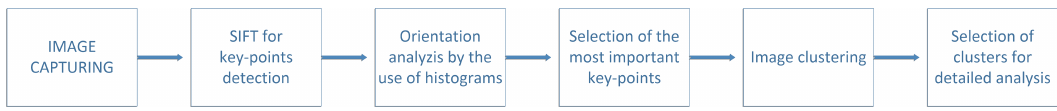
Figure 3. The captured image goes through the following stages of processing in the proposed system: global and local features extraction and comparison. In the first one an image is clustered into smaller parts containing suspicious symptoms over the skin. These clusters are compared by the use of histograms and selected ones are forwarded to detection phase in which Convolutional Neural Network performs evaluation of these symptoms.